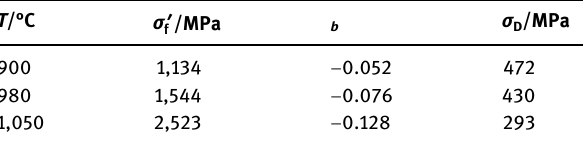
Table 2: Parameters of the Basquin equations and fatigue limits